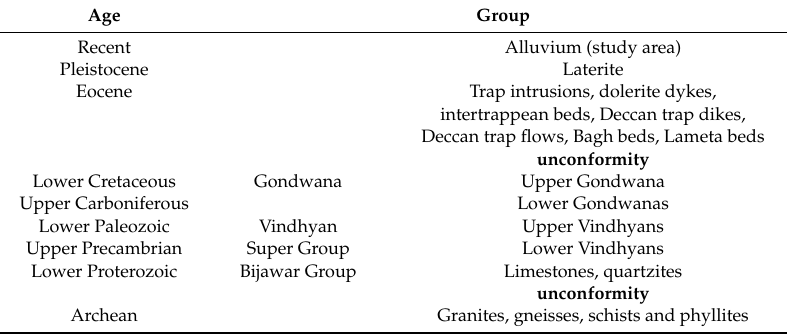
Archean Granites, gneisses, schists and phyllites